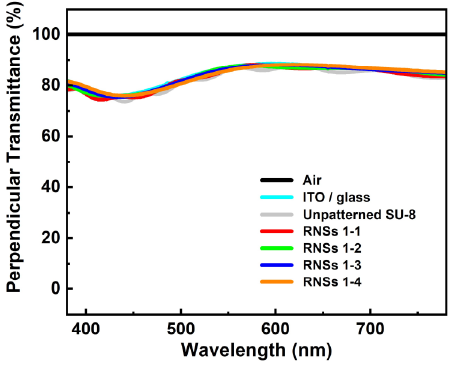
Figure 3. Perpendicular visible wavelength transmittance of different patterned polymers. RNSs 1-1, RNSs 1-2, RNSs 1-3, and RNSs